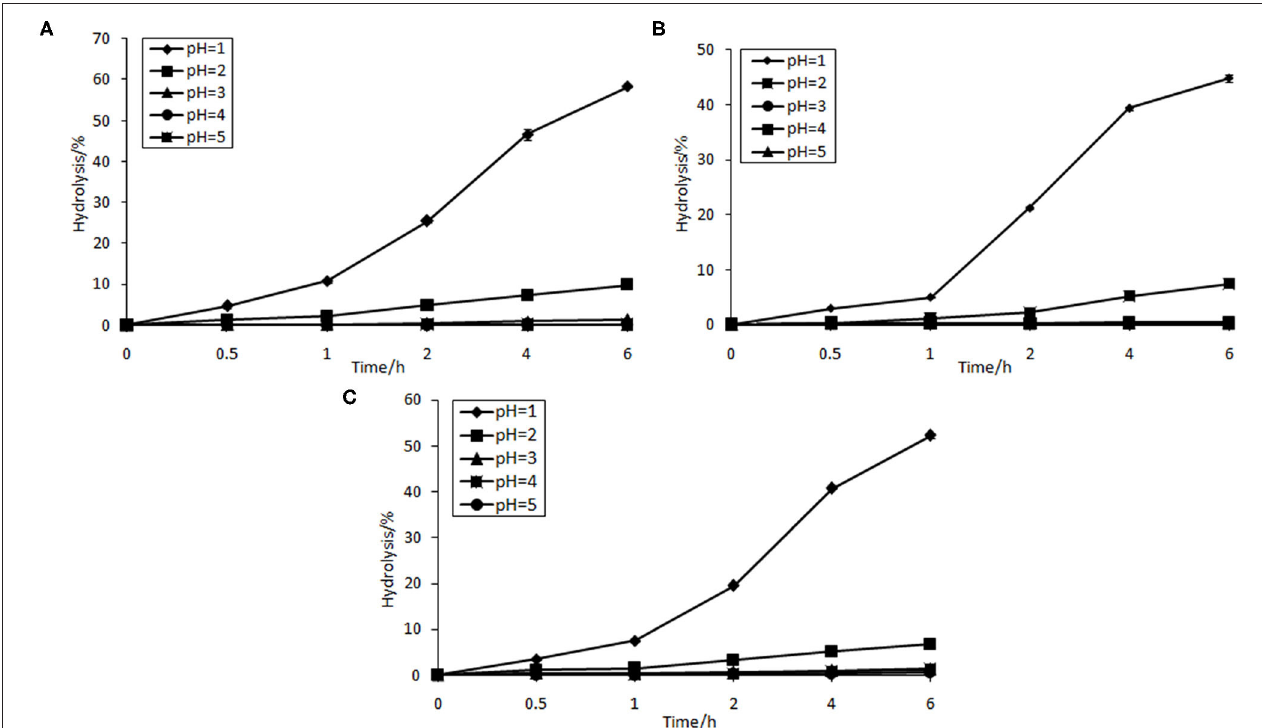
FIGURE 3 | Resistance of FOS (A) , GPs (B) , and GOs (C) to various artificial gastric juice.